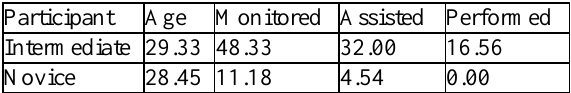
Table 2. Participant Endoscopic Surgery